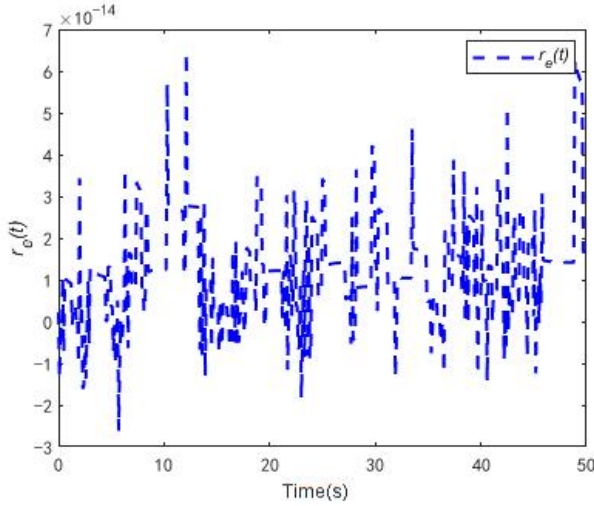
r t without fault. e